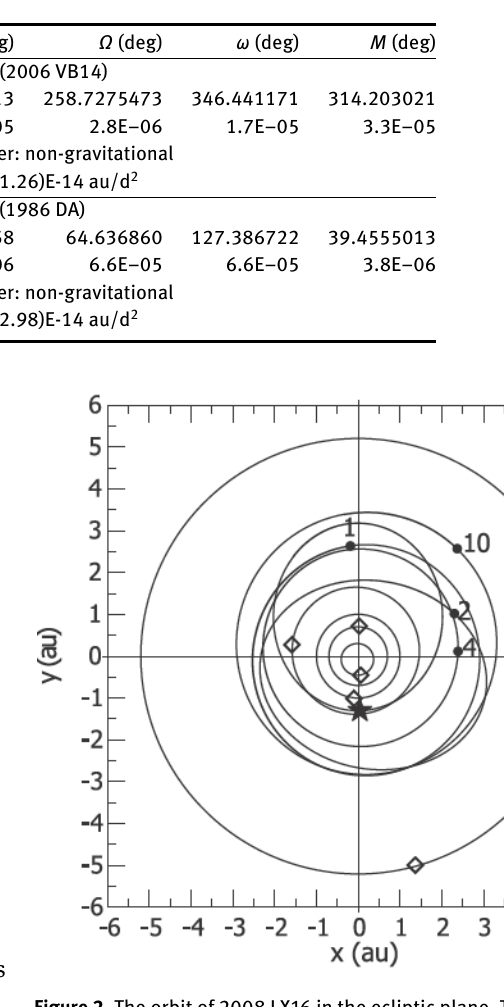
Figure 2. The orbit of 2008 LX16 in the ecliptic plane. The position of the planets, the asteroid 2008 LX16, dwarf planet (1) Ceres and three massive asteroids: (2) Pallas, (4) Vesta and (10) Hygiea are presented for the epoch 2008 June 15, i.e. for the date of first obser- vation at Siding Spring